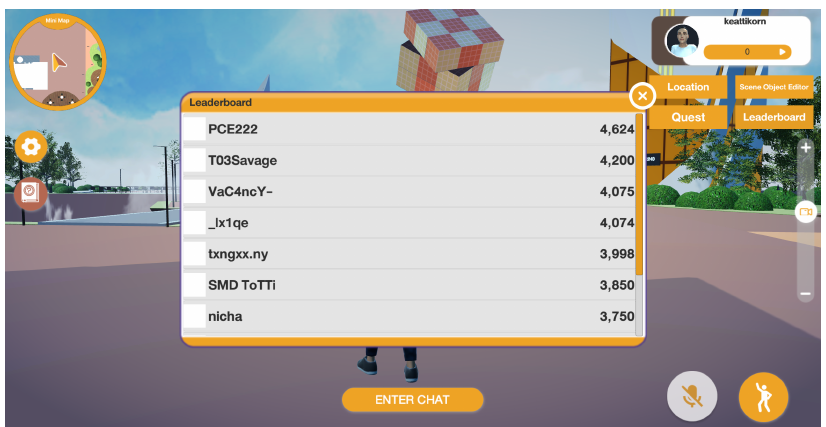
Figure 10. Digital industry integration (DII) interior with an example of an interactable NPC, named Adam. The user interface displayed on the top centre is “Press F to talk”.